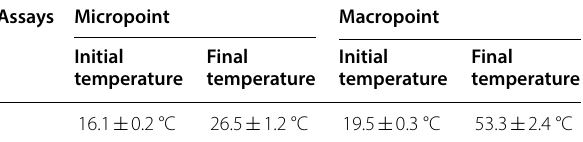
Table 1 Initial and final temperature measurement